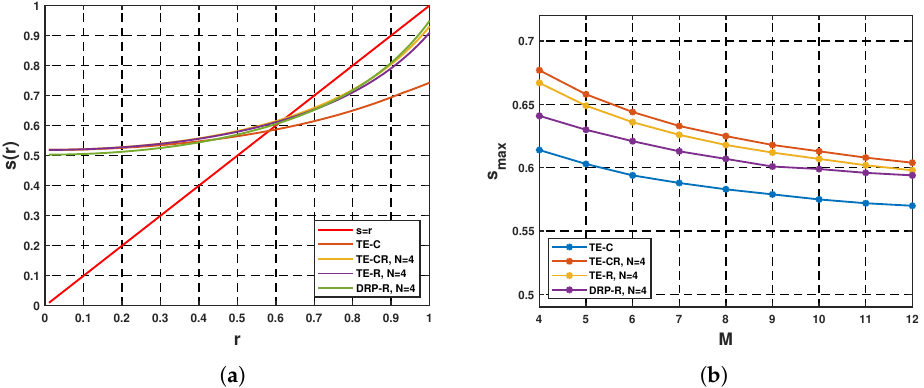
Figure 4. Stability curves of different FD methods: ( a ) stability factors varying with the Courant numbers r and ( b ) maximum stability factors satisfying r ≤ s with different orders M .